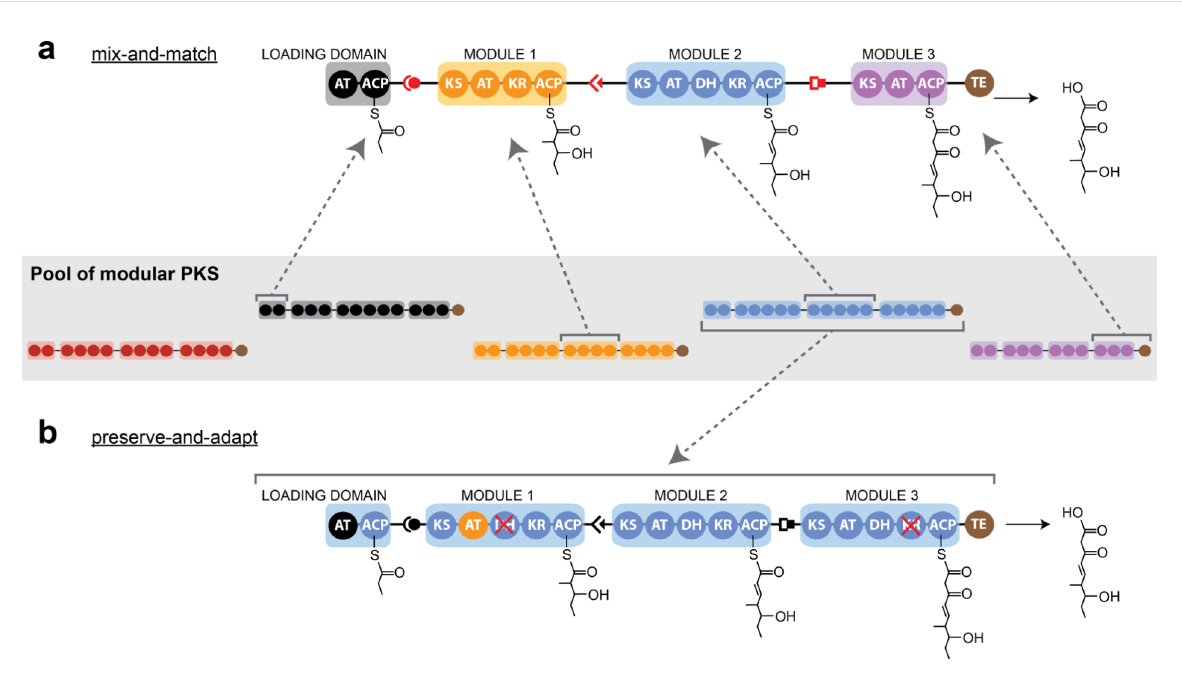
Figure 3: Strategies of megasynthase engineering. a) Mix-and-match approach: A hypothetical chimeric PKS is assembled module by module from a pool of available PKS. In such approach, docking domains (represented in red color) are adapted for coding the sequence of assembly. b) Preserve- and-adapt approach: A modular PKS, selected from the native pool by beneficial properties (see text) is used as a scaffold and adapted in catalytic functions and substrate